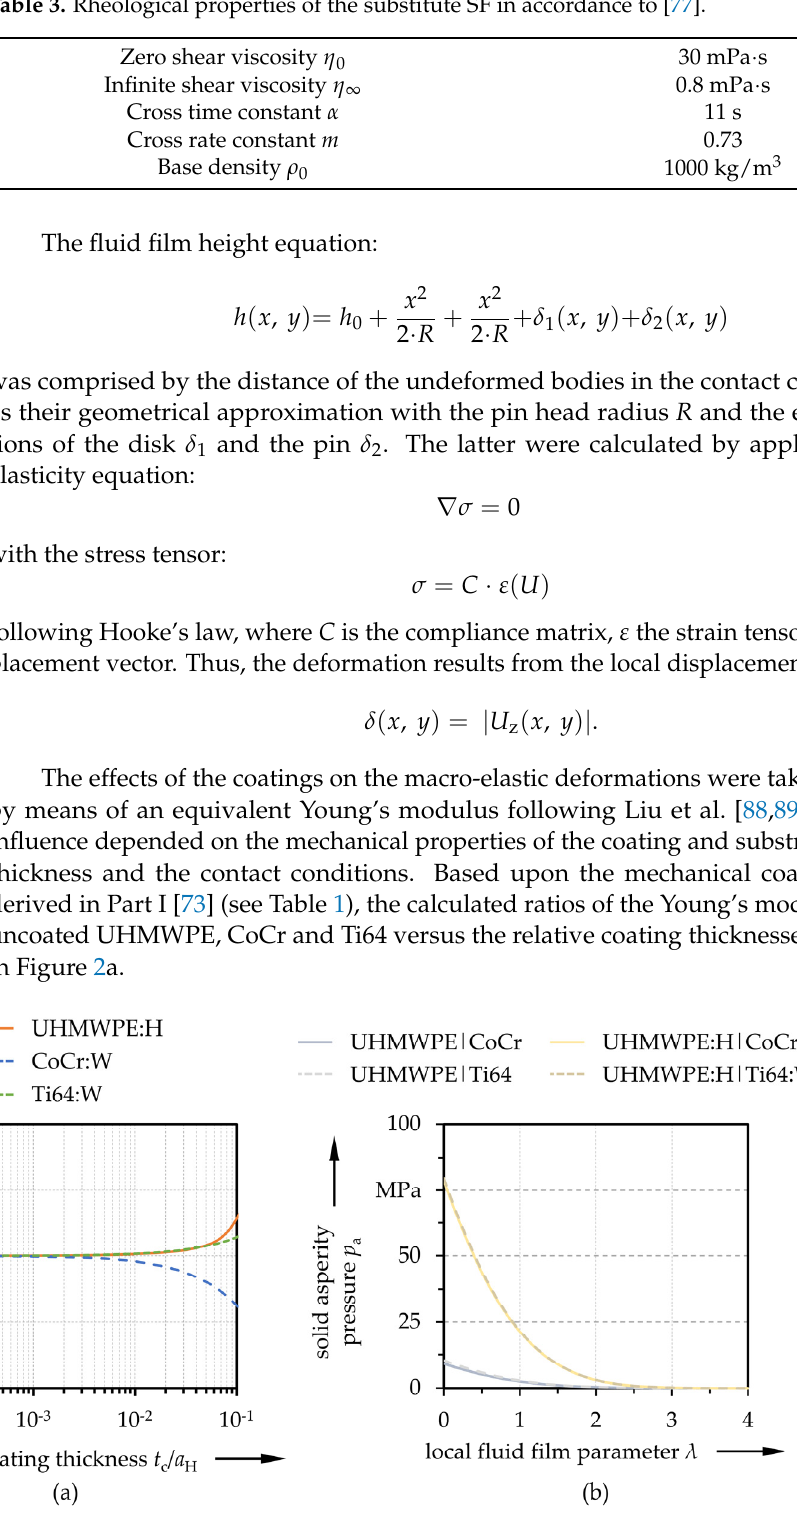
Figure 2. Influence of the coating on the Young’s modulus in dependency of the relative coating thickness ( a ) and solid asperity contact pressure versus local fluid film parameter ( b ).